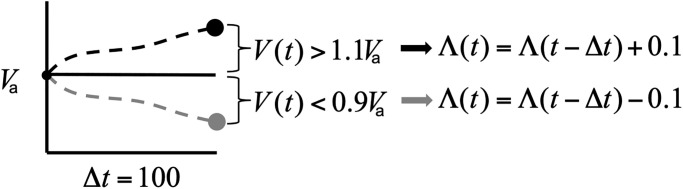
Dose adjustment schematic.Schematic description of the dose adjustment rules based on the measured total tumor volume shown here, attempting to maintain a total tumor burden at Va, though the same rules apply to Vb.